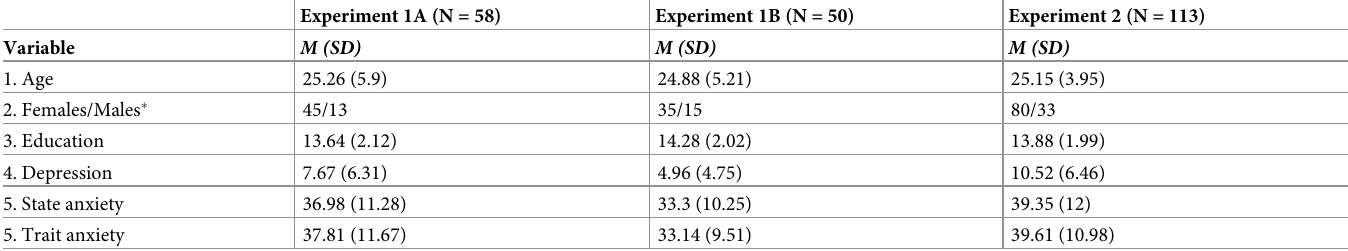
Table 1. Demographic characteristics of the participants in the three experiments (means and standard